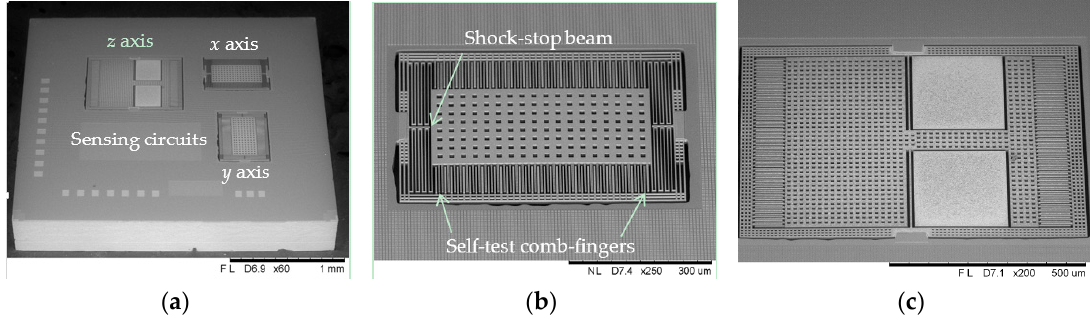
Figure 2. ( a ) SEM image of the monolithic CMOS MEMS three-axis accelerometer; ( b ) SEM image of in-plane ( x -axis or y -axis) sensor, and ( c ) SEM image of z -axis